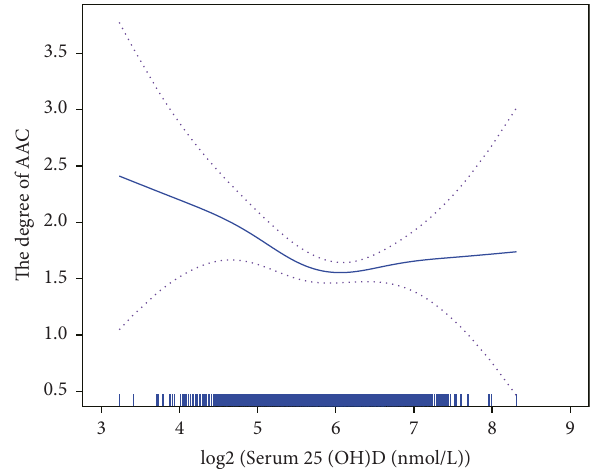
Figure 2: Te association between serum 25(OH)D and the degree of AAC.